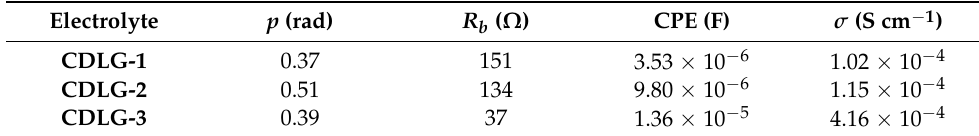
Table 1. Ionic conductivity and the parameters fitting of the EEC.